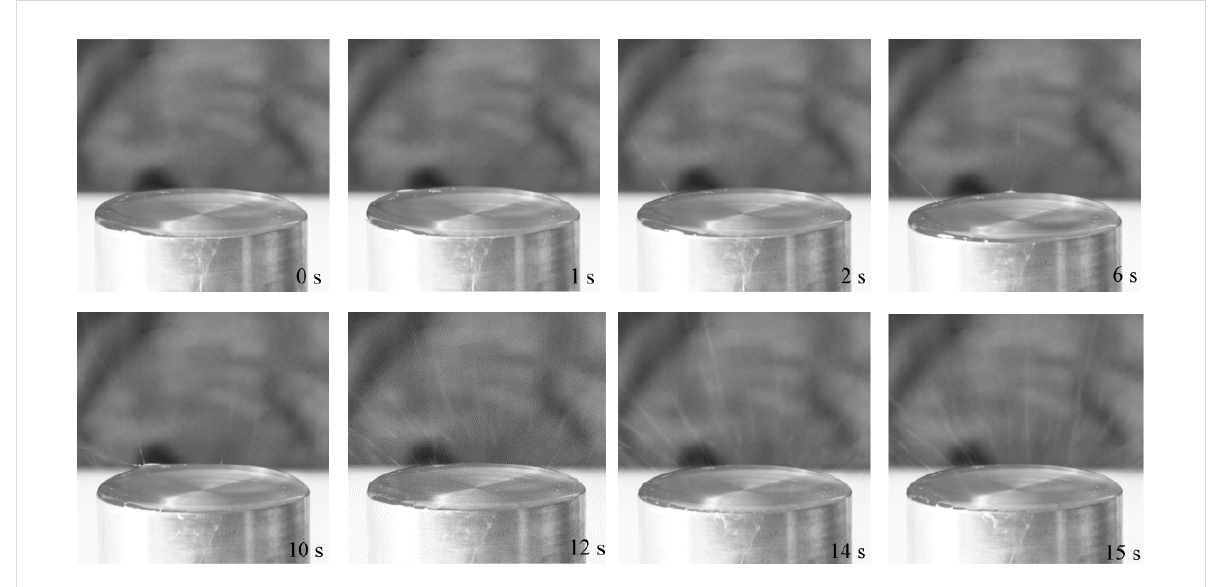
Figure 4: Time-lapse images (0–15 s) of the jet initiation process of OSFSE. The voltage was turned on and held at an amplitude of 40 kV throughout the spinning process.